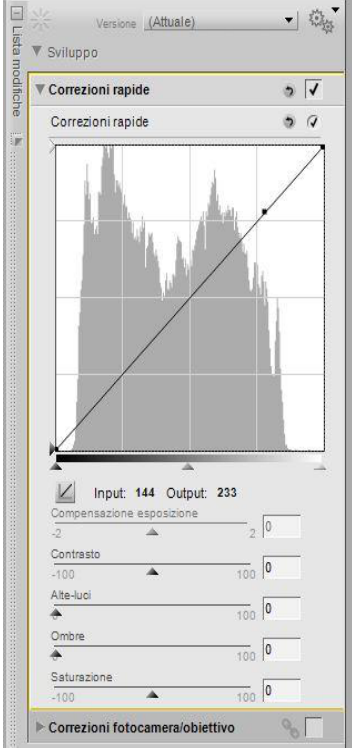
Figure 5. Corrections of camera